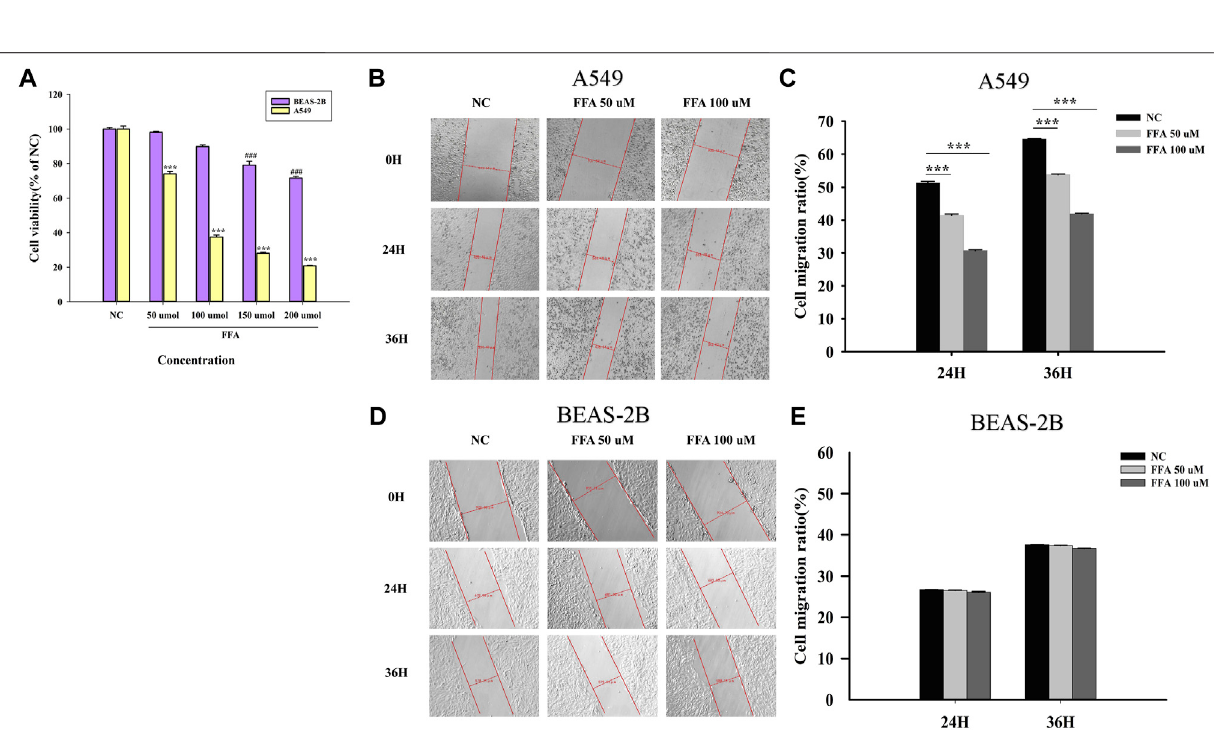
Frontiers in Molecular Biosciences |